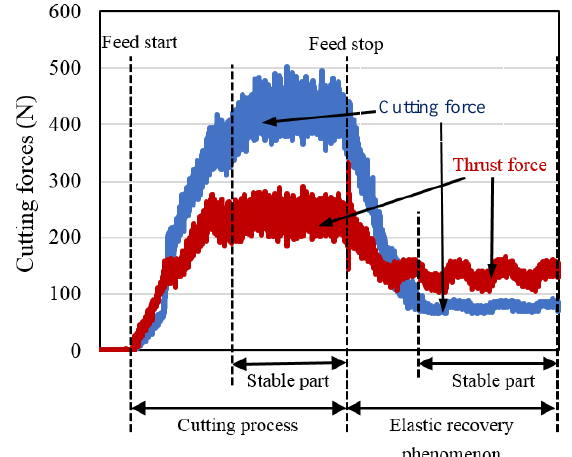
Figure 8. Waveforms of cutting forces measured in the orthogonal cutting of NiTi alloy (v = 20 m/min, f = 0.05 mm/rev, t = 2 mm).